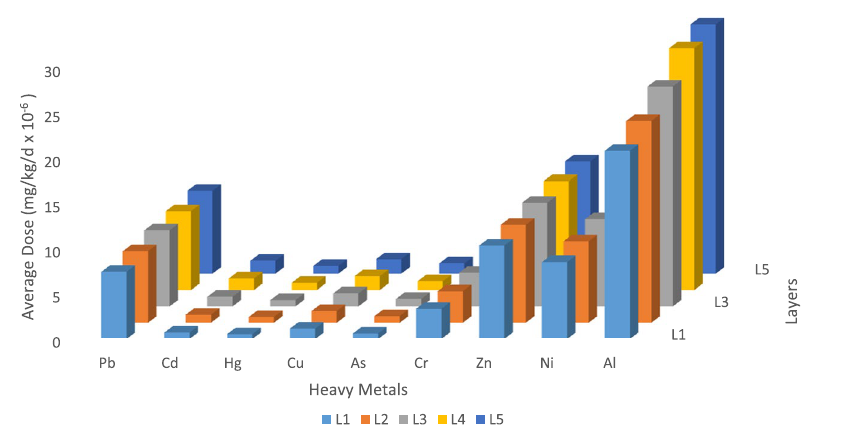
Figure 5. Average Daily Dose intake of the Heavy